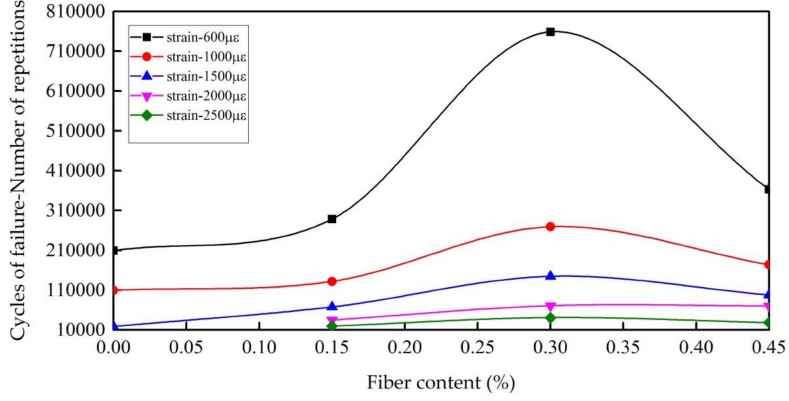
Figure 7. Effect of fiber content on fatigue life at the same strain